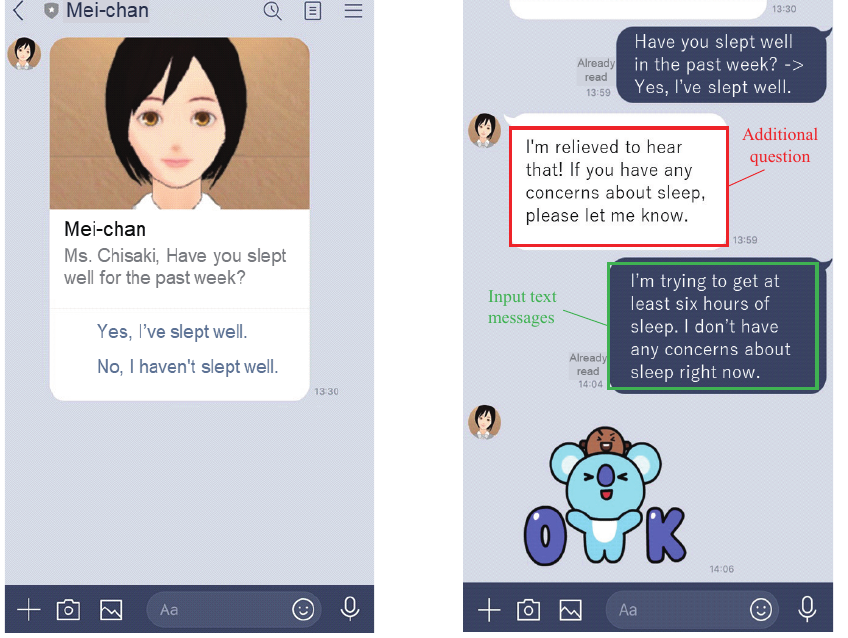
Figure 3. Screenshots of user’s LINE application operated by the proposed service (added